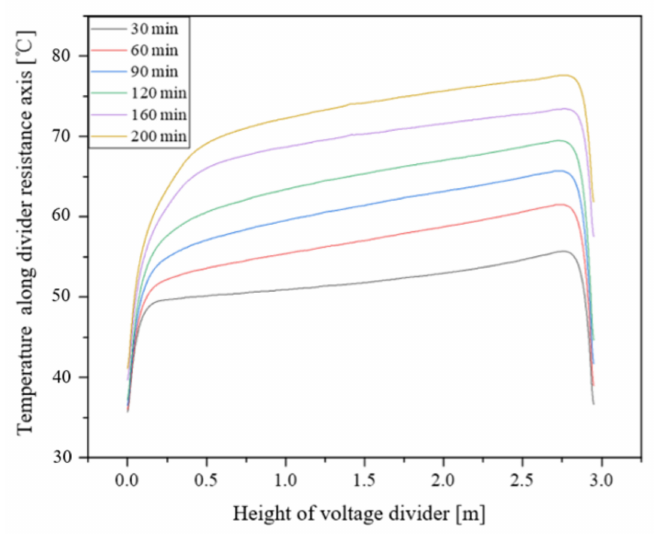
Figure 5. Temperature distribution at the axis of the divider resistor.